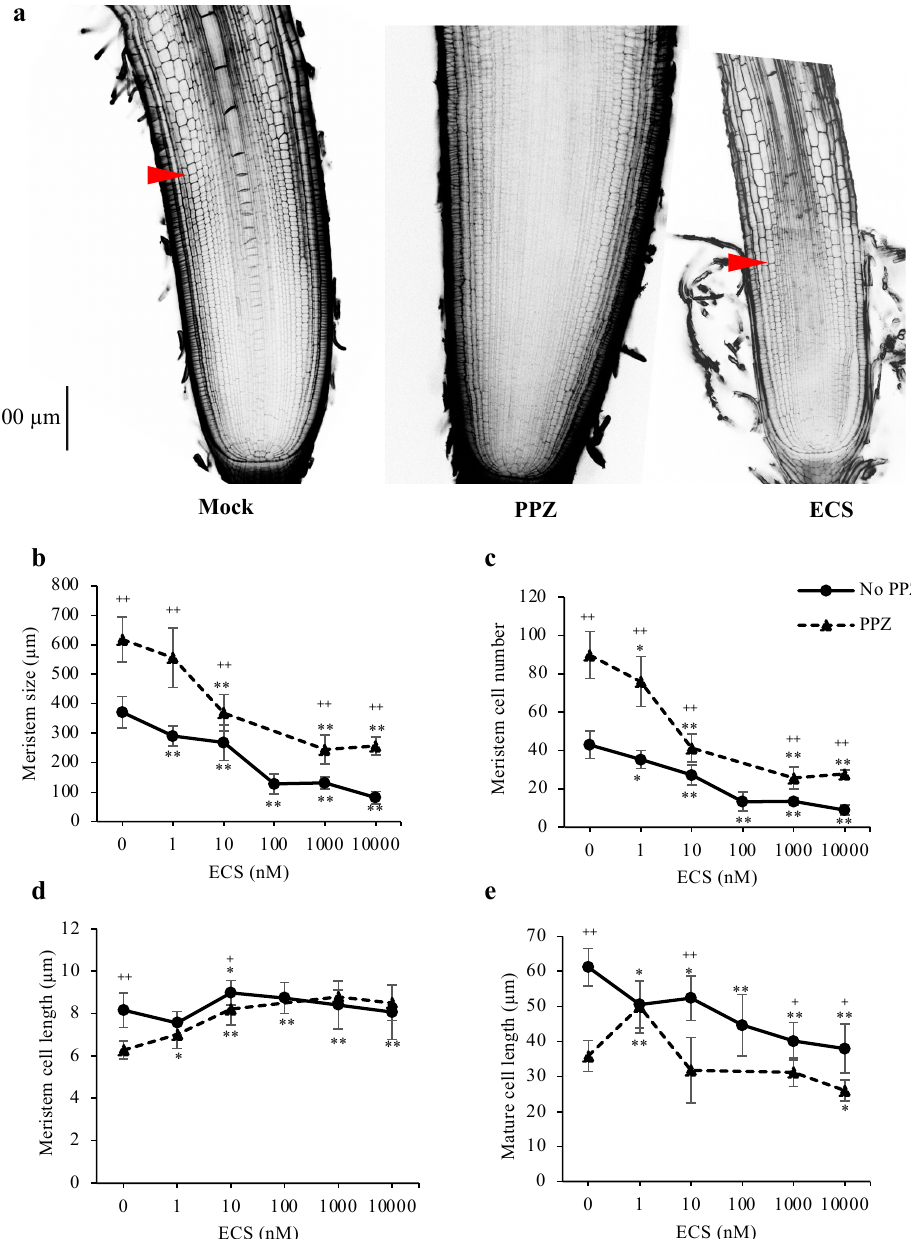
Figure 2. Effect of ECS and PPZ treatments on rice root meristem and cell elongation in primary root tips. Seedlings were grown in the absence and presence of PPZ for 5 d, and then treated with ECS for 24 h. ( a ) Confocal microscopy images of rice root meristems treated with mock, PPZ (4 µ M) or ECS (10 nM). Scale bar = 100 µ m. Arrowheads mark the end of the meristem zone; the PPZ- treated root had large meristem that the end of the meristem zone was not present in the image. ( b – d ) Quantifications of root meristem size ( b ), meristem cell number ( c ) and average meristem cell length ( d ) were determined from cortical cells in the 4th cortical layer by measuring from the QC to the first elongated cell. Mature cell length ( e ) was determined from the average length of five adjacent mature cortical cells. Data are means ± SD ( n ≥ 6 biological replicates). Significant differences between the treatment and the mock control are indicated by * and ** for p < 0.05 and 0.001, respectively. Significant differences between PPZ and no PPZ (with the same ECS concentration) are indicated by + and ++ for p < 0.05 and 0.001,